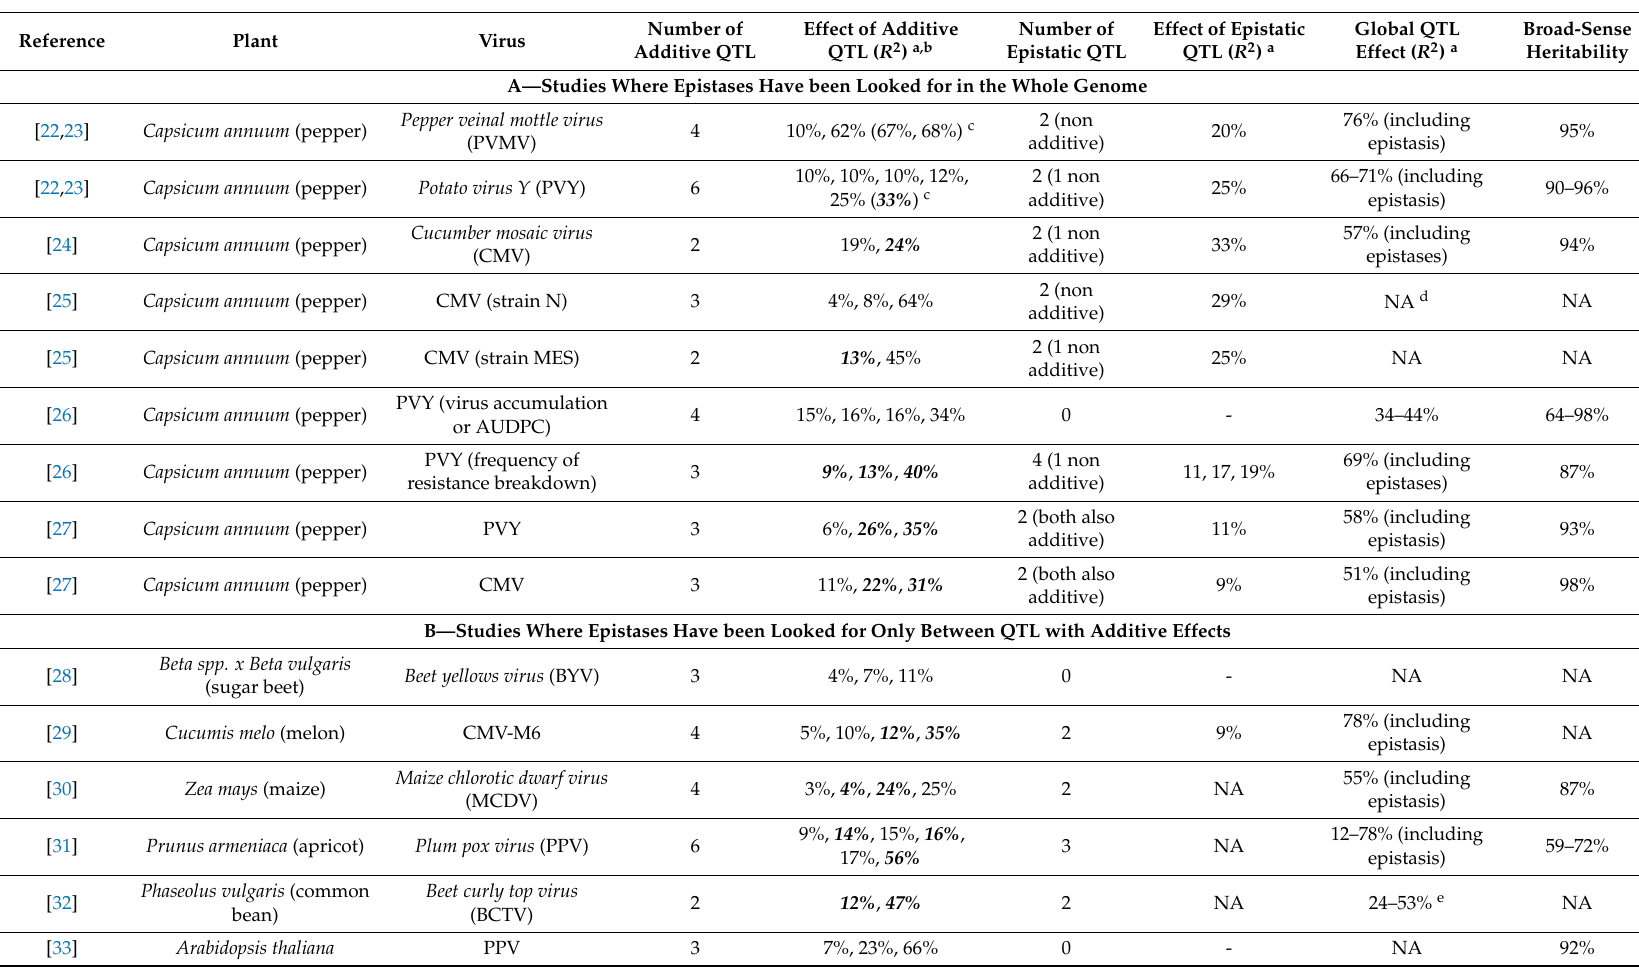
Table 1. Published data on virus resistance QTL in plants. (Only studies where epistases between resistance QTL have been looked for are indicated.)